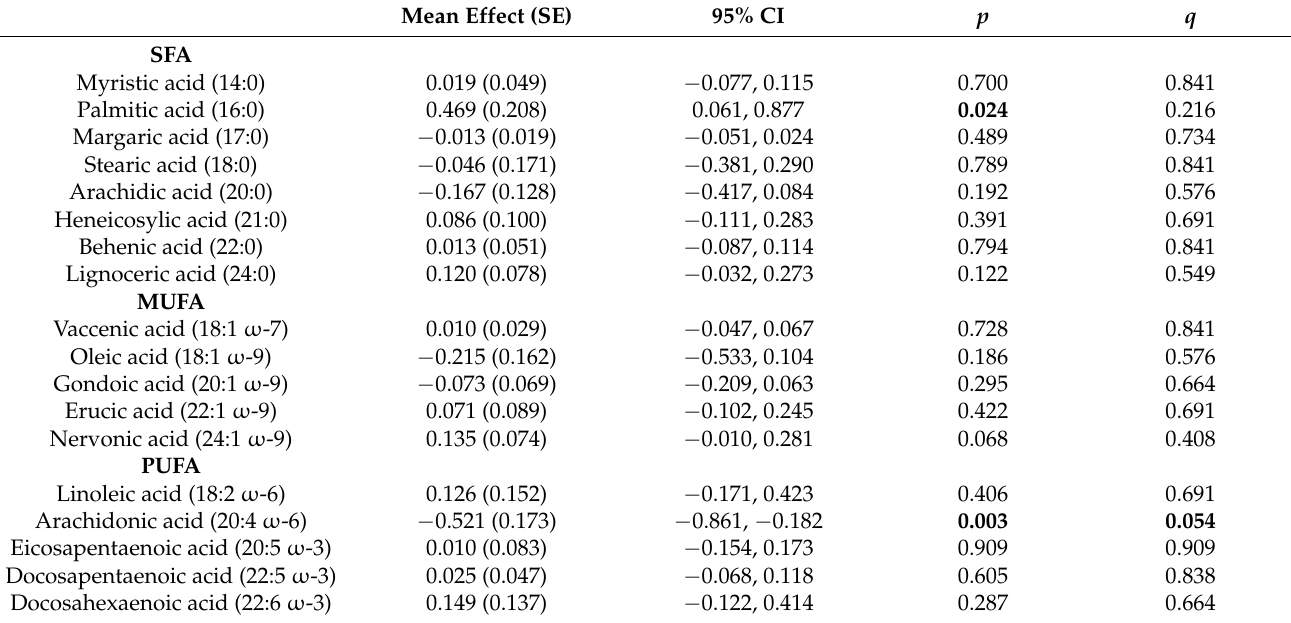
Table 5. Effect of the enriched fish (EF) versus the conventional fish (CF) diet on red blood cell (RBC) membrane fatty acid composition (%) (treatment